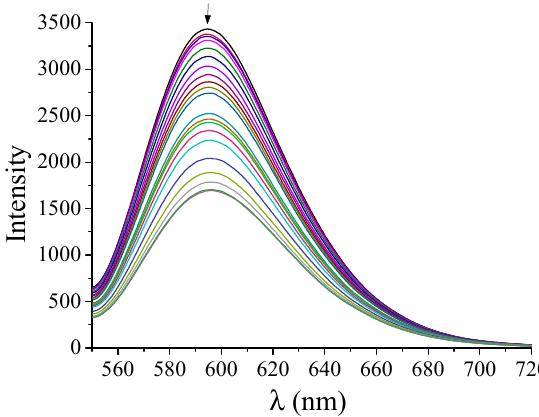
Figure 7. Fluorescence emission spectra ( λ exc = 540 nm) for EB–DNA ([EB] = 20 µ M, [DNA] = 26 µ M) in bu ff er solution in the absence and presence of increasing amounts of NL004 (up to the value of r = [NL004] / [DNA] = 0.45). The arrow shows the changes of intensity upon increasing amounts of NL004.